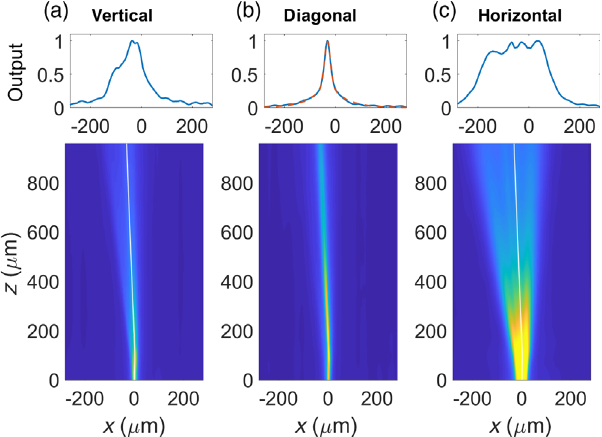
FIG. 5. Light behavior for tilted input. Light propagation when the input beam is tilted by approximately 4° with respect to the normal at the input interface and is linearly polarized (a) parallel to axis y , (b) at 45°, and (c) parallel to the axis x . The top panels report the intensity cross section at z ¼ 960 μ m (solid blue line), whereas the dashed red line is the best fit accounting for light diffusion (see Appendix E), providing a width of 20 μ m to be compared with the value of approximately 50 μ m measured in the linear case. The solid white line in (a) and (c) is the trajectory corresponding to the self-trapped beam plotted in (b). The input power is 50 mW, and the input waist is 4 μ m.